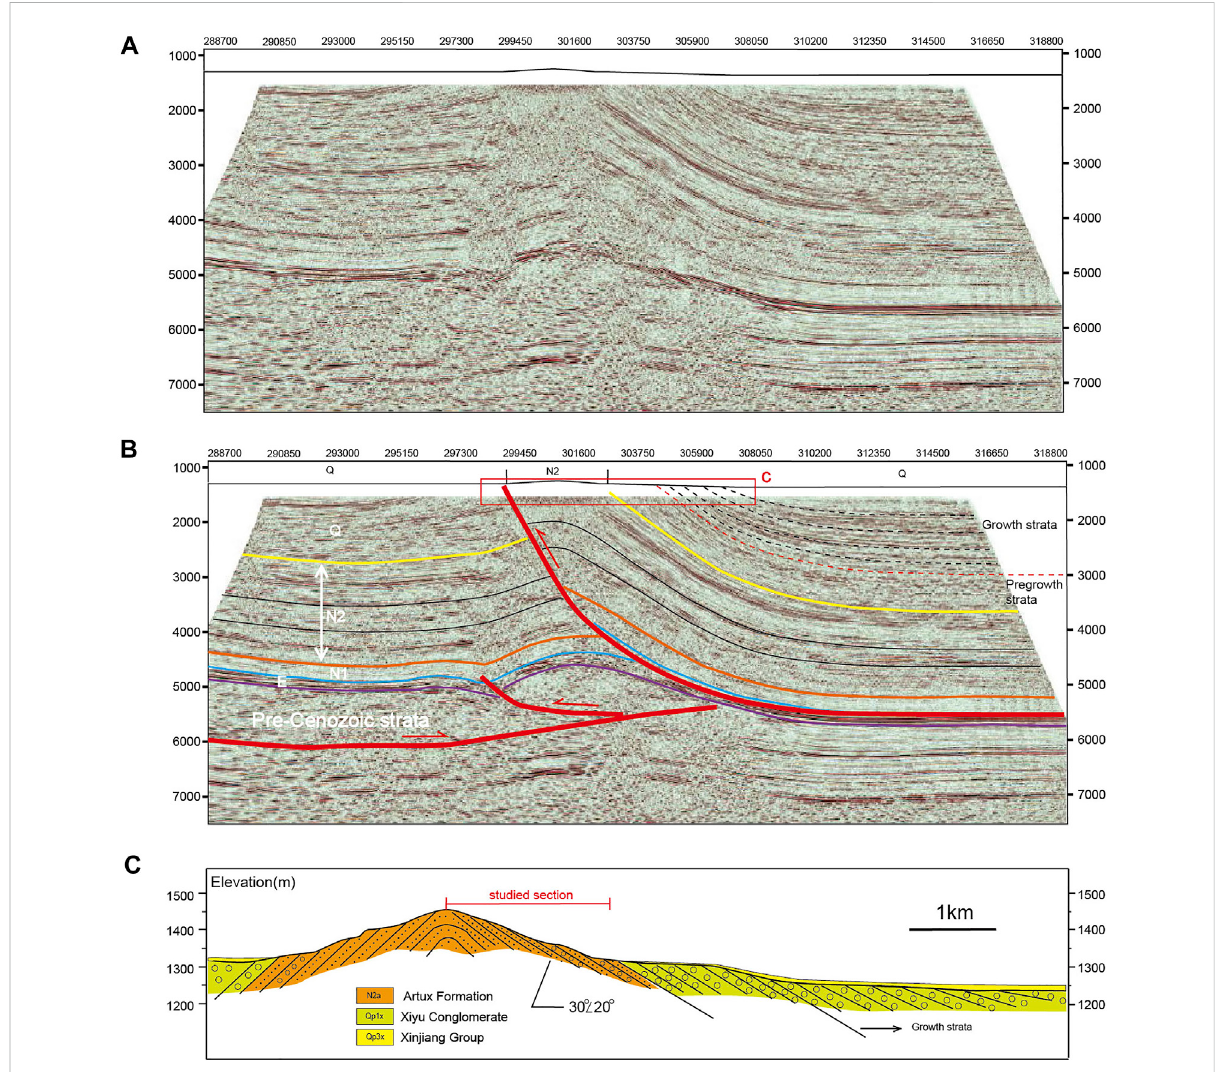
FIGURE 3 (A) and (B) , Seismic re fl ection pro fi le and its interpretation (by Gao, 2012). The location of the survey line was displayed in Figure 2B. The pro fi le shows that the boundary (yellow solid line) between the Artux Formation and the Xiyu Conglomerate is near the top of the studied successions. The basallayer(reddotline)ofthegrowthstrata(blackdotlines) isdepositedwithintheXiyuConglomerate. (C) ,Theschematicdiagramforthesampling section as demonstrated in (B)